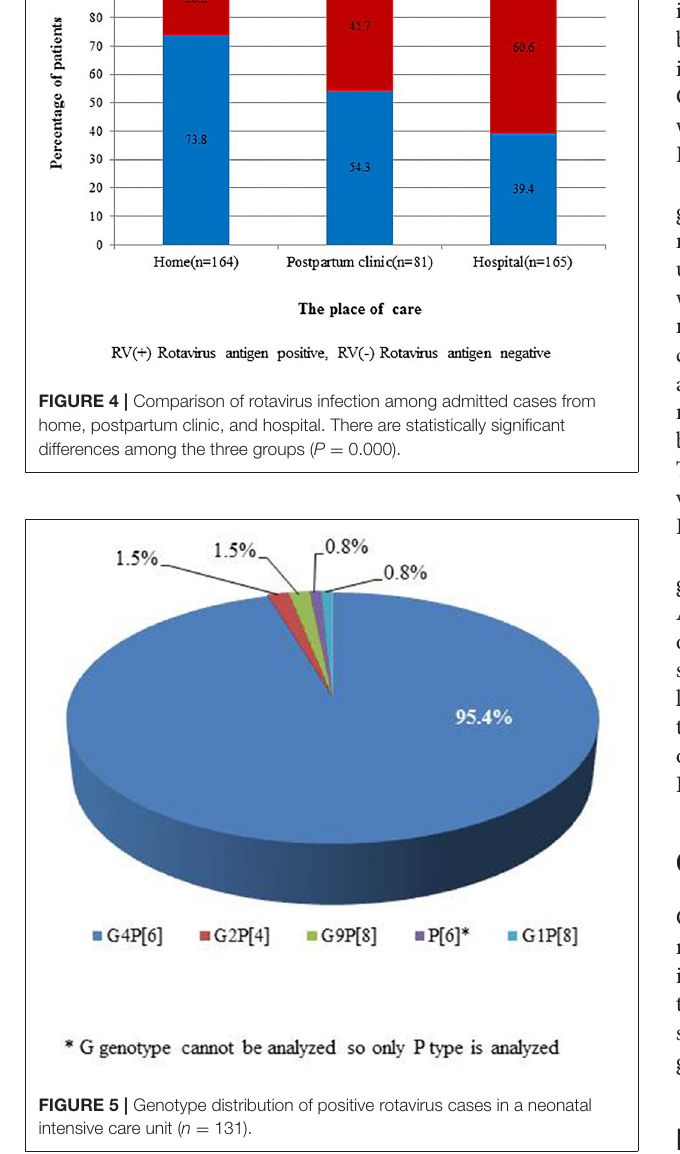
RV infection tends to be predominant in the winter (32).